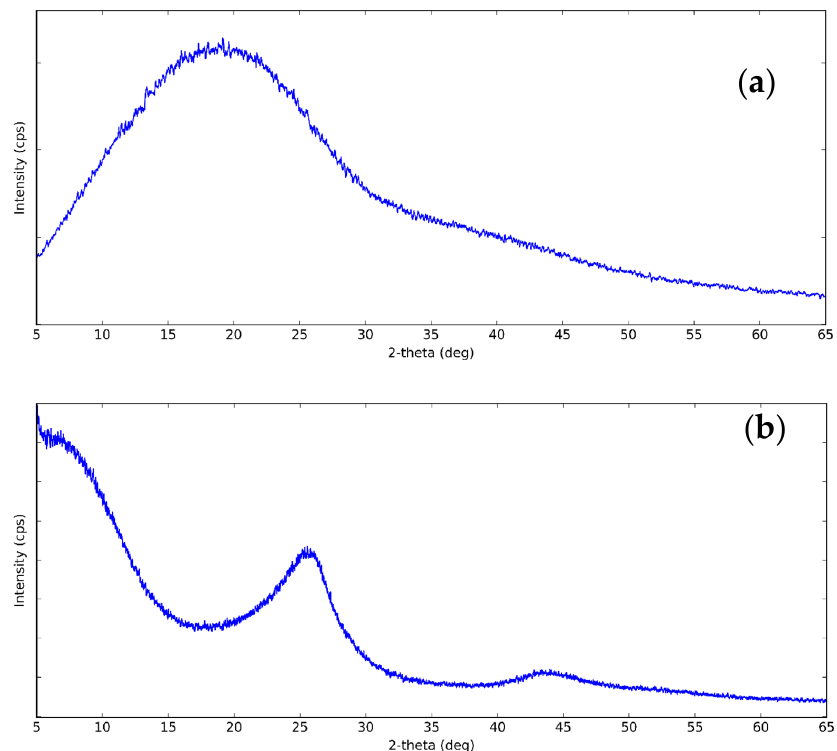
Figure 1. XRD pattern of ( a ) carbon nanosphere (CNS) and ( b ) carbon nanopowder (CNP) at the following XRD conditions: X-Ray: 40 kV, 30 mA. Scan speed: 3.0 degree/min.